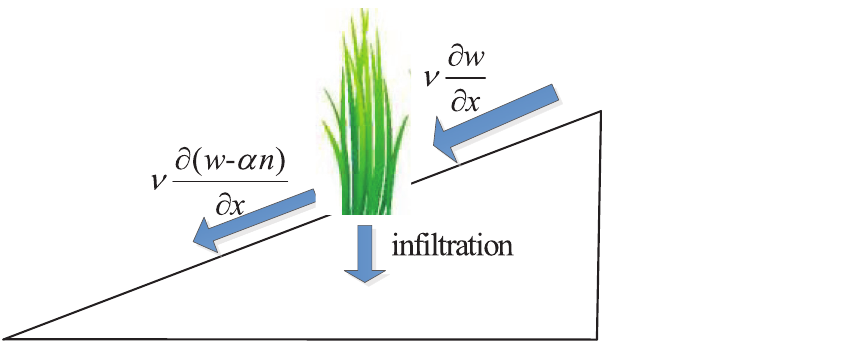
model the surface runoff without biomass and v @ ð w (cid:0) a n Þ @ x